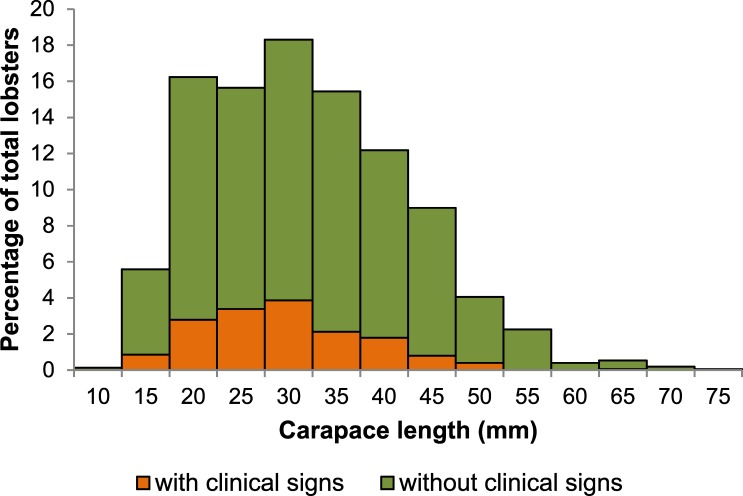
Size distribution of lobsters.Size distribution (carapace length, in mm) of the total sample (N = 1503) of spiny lobsters (P. argus) throughout the study. The orange column sections represent lobsters with clinical signs of PaV1 infection (N = 243) and the green column sections represent lobsters with no clinical signs of PaV1 infection (N = 1260). Numbers in X-axis denote the upper limit of each size class.